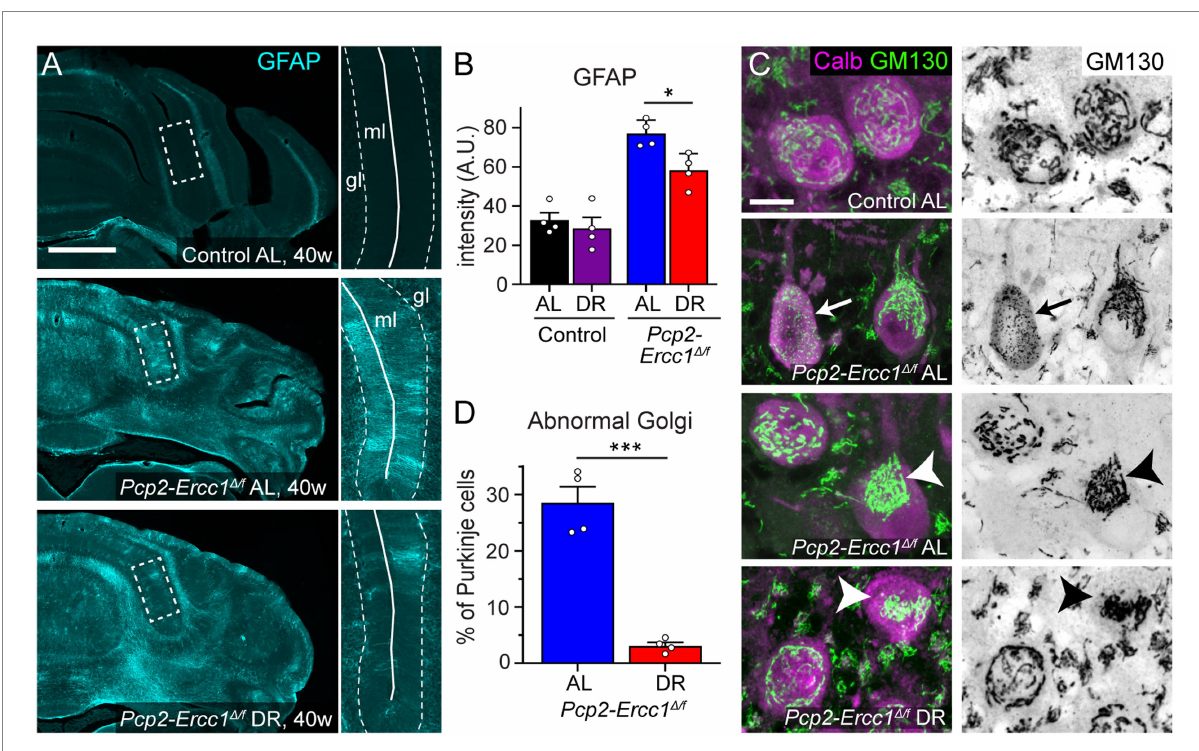
FIGURE 2 Dietary restriction reduces GFAP-immunostaining and Golgi apparatus abnormalities in Pcp2-Ercc1 Δ /f mice. (A,B) Representative images and bar graph (means ± SE) of GFAP immunofluorescence illustrating increased GFAP immunostaining in Pcp2 - Ercc1 Δ /f cerebellum compared to control, and reduced GFAP-staining in the molecular layer (ml) of DR compared to AL Pcp2 - Ercc1 Δ /f cerebellum. ( n = 4/group); * p < 0.05 (unpaired t -test). (C,D) Confocal images and bar graph (means ± SE) showing reduced amount of Golgi apparatus morphological abnormalities in 40 week old DR compared to AL Pcp2 - Ercc1 Δ /f Purkinje cells, examined using immunostaining of the cis-Golgi scaffold protein GM130. In control Purkinje cells the GM130 staining outlines a network of linear profiles throughout the cell body. In ERCC1-deficient mice 2 main types of changes occur in a subset of Purkinje cells: (1) fragmentation of linear profiles into smaller elements (arrow) and (2) more frequently, redistribution of unfragmented or fragmented Golgi stacks to part of the cell body (arrow heads). ( n = 4/group); *** p < 0.001 (unpaired t -test). Scale bars: 500 μm (A) , and 10 μm (C)